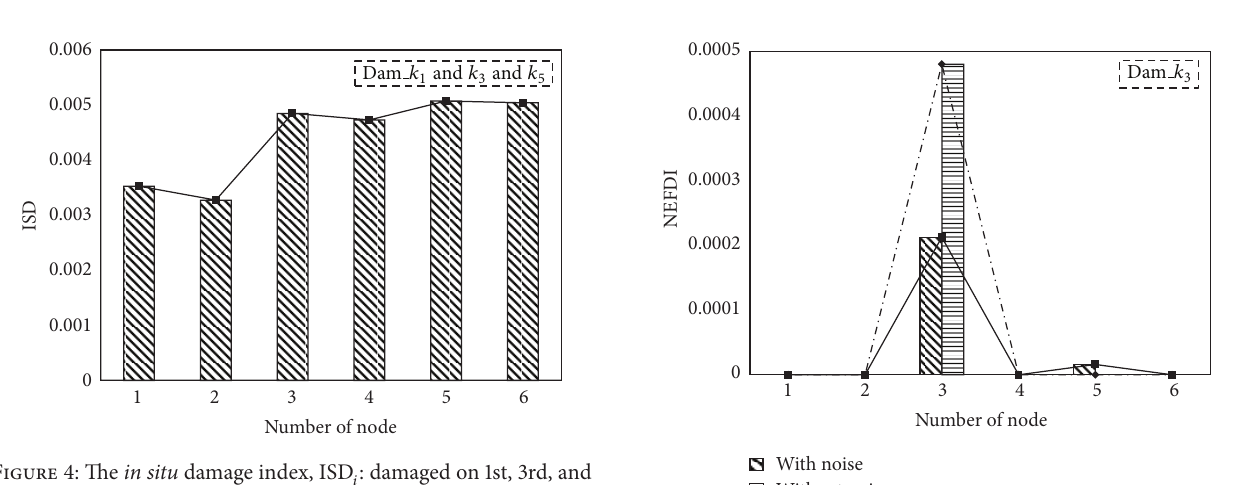
Figure 4: The in situ damage index, ISD 𝑖 : damaged on 1st, 3rd, and